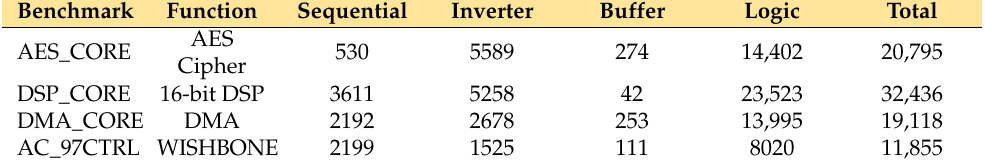
Table 1. The hardware description of IWLS benchmarks for the Specification of design at the 45 nm node.